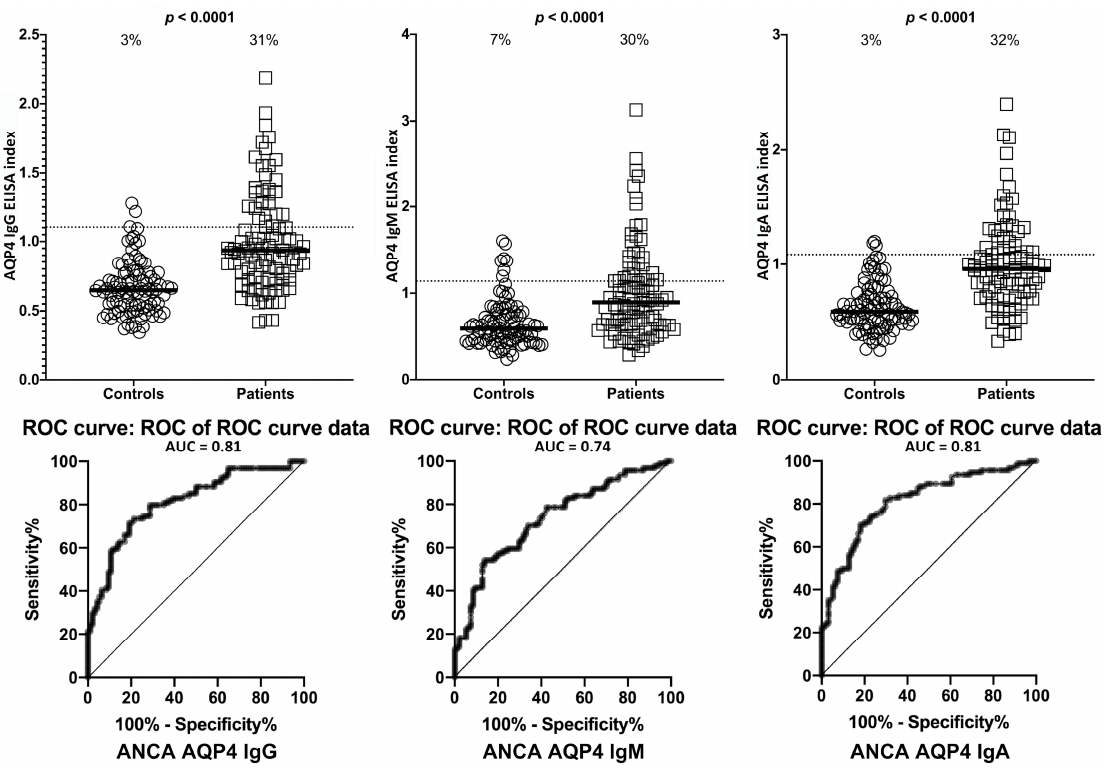
Figure 9. Percentage of elevation of IgG, IgM, and IgA antibodies against aquaporin-4 (AQP4) in 94 patients positive for ANCA and in 94 healthy controls. Dotted lines indicate the cutoff for positivity used in each assay, as calculated by ROC analysis. The percentage of elevation is indicated on top of each distribution, while bars indicate the corresponding median. The AUC for AQP4 IgG was 0.81, 0.74 for AQP4 IgM, and 0.81 for AQP4 IgA. Table 3. Numbers and % elevation of IgG, IgM, and IgA antibodies against lipopolysaccharides (LPS), zonulin+occludin, S100B and aquaporin-4 (AQP4) in sera positive or negative for ASCA or ANCA.